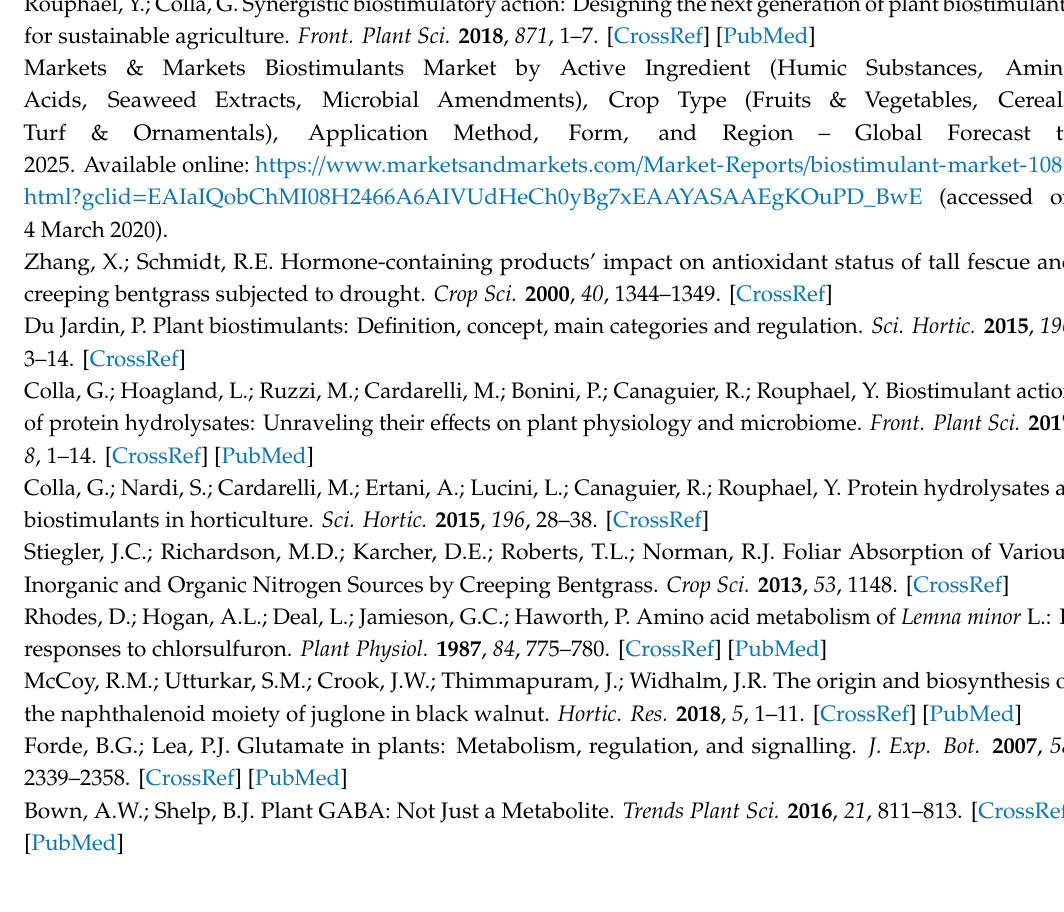
Table S1: Fragments of each labeled and unlabeled amino acid from glutamate-[ 15 N 1 ] as analyzed by GC-MS; Table S2: Fragments of each labeled and unlabeled amino acid from glutamate-[ 13 C 515 N 1 ] as analyzed by